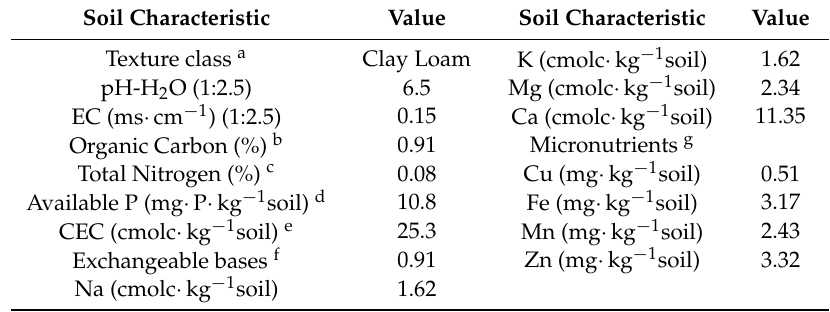
Table 2. Soil physicochemical characteristics of the 0 to 30 cm soil layer of the experimental sites in Huletegna Choroko at the initiation of the experiments in